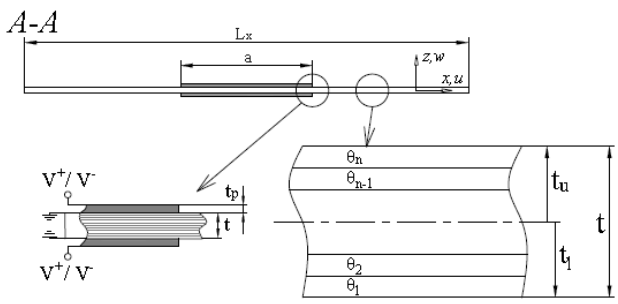
Figure 1. Composite structure reinforced by piezoelectric (PZT) layers.